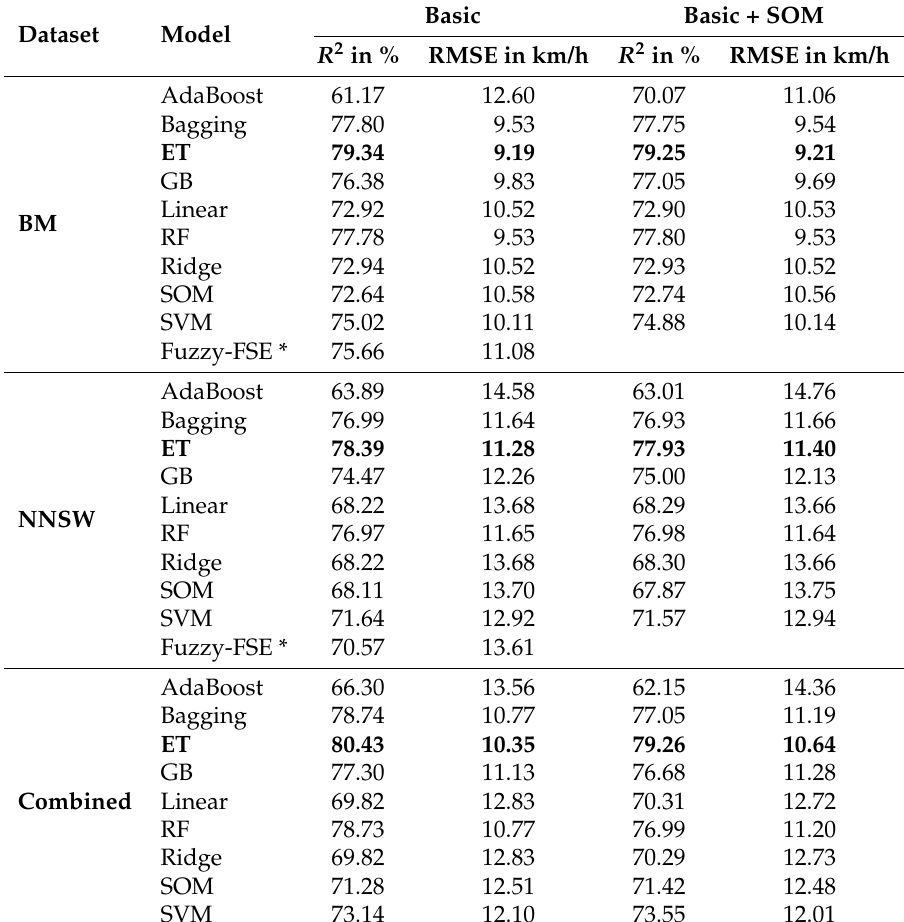
Table 5. Regression results for the average speed estimation on the BM dataset (Chile), the NNSW dataset (Australia), and the combined dataset. * As a comparison, we include the best estimation results of the rule-based Fuzzy-FSE of Guth et al. [9] for the BM and the NNSW